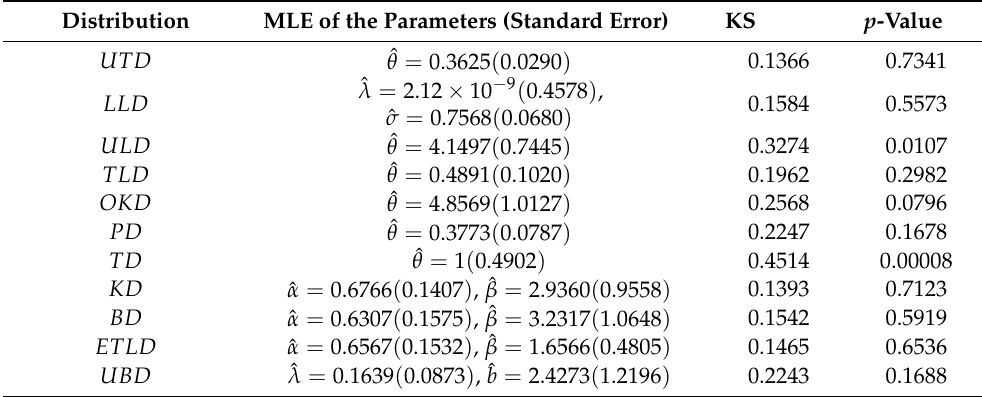
Listed in Table 11 are the MLEs of the parameters and the observed KS test statistic for each distribution. In terms of KS value and p -value, UTD is the best model. On the basis of Table 12, it can be seen that the UTD has the largest log-likelihood value, while the AIC, AICc, CAIC, and BIC values are the smallest. Therefore, the UTD model fits the secondary reactor pump failure data better than the other models. Table 11. The MLEs of the parameters and their standard errors, KS values and the associated p -values.